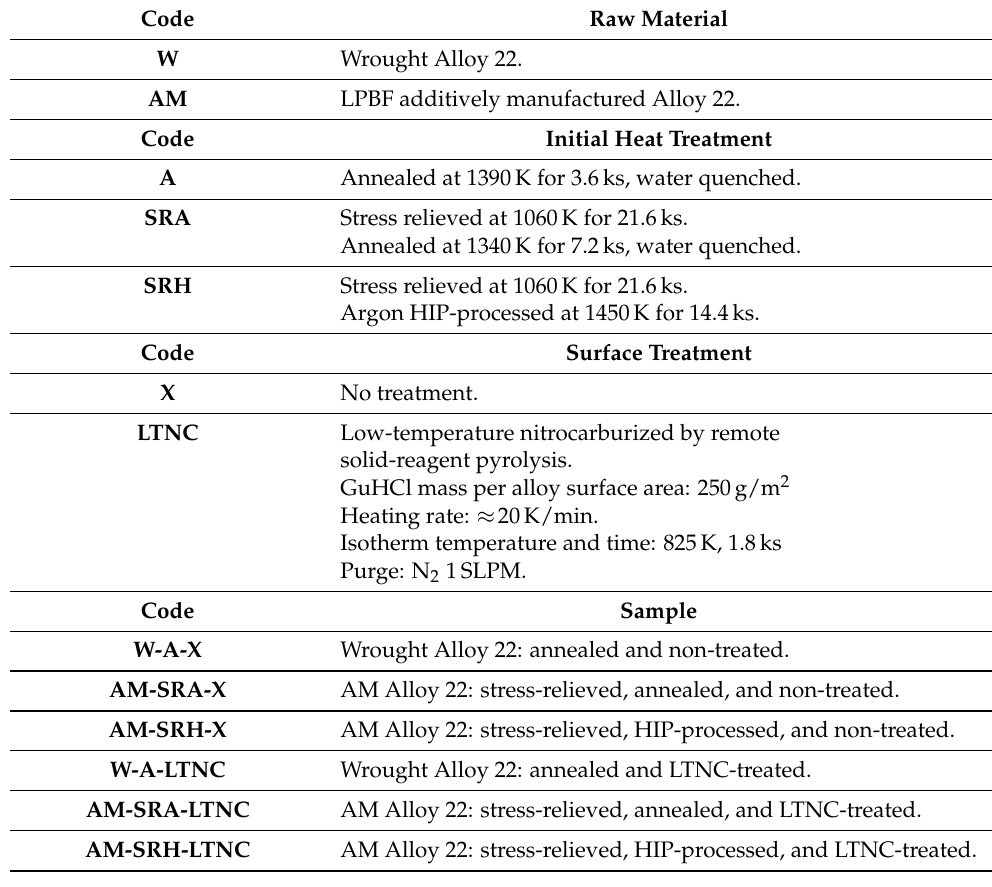
Table 2. Material- and Treatment Codes.